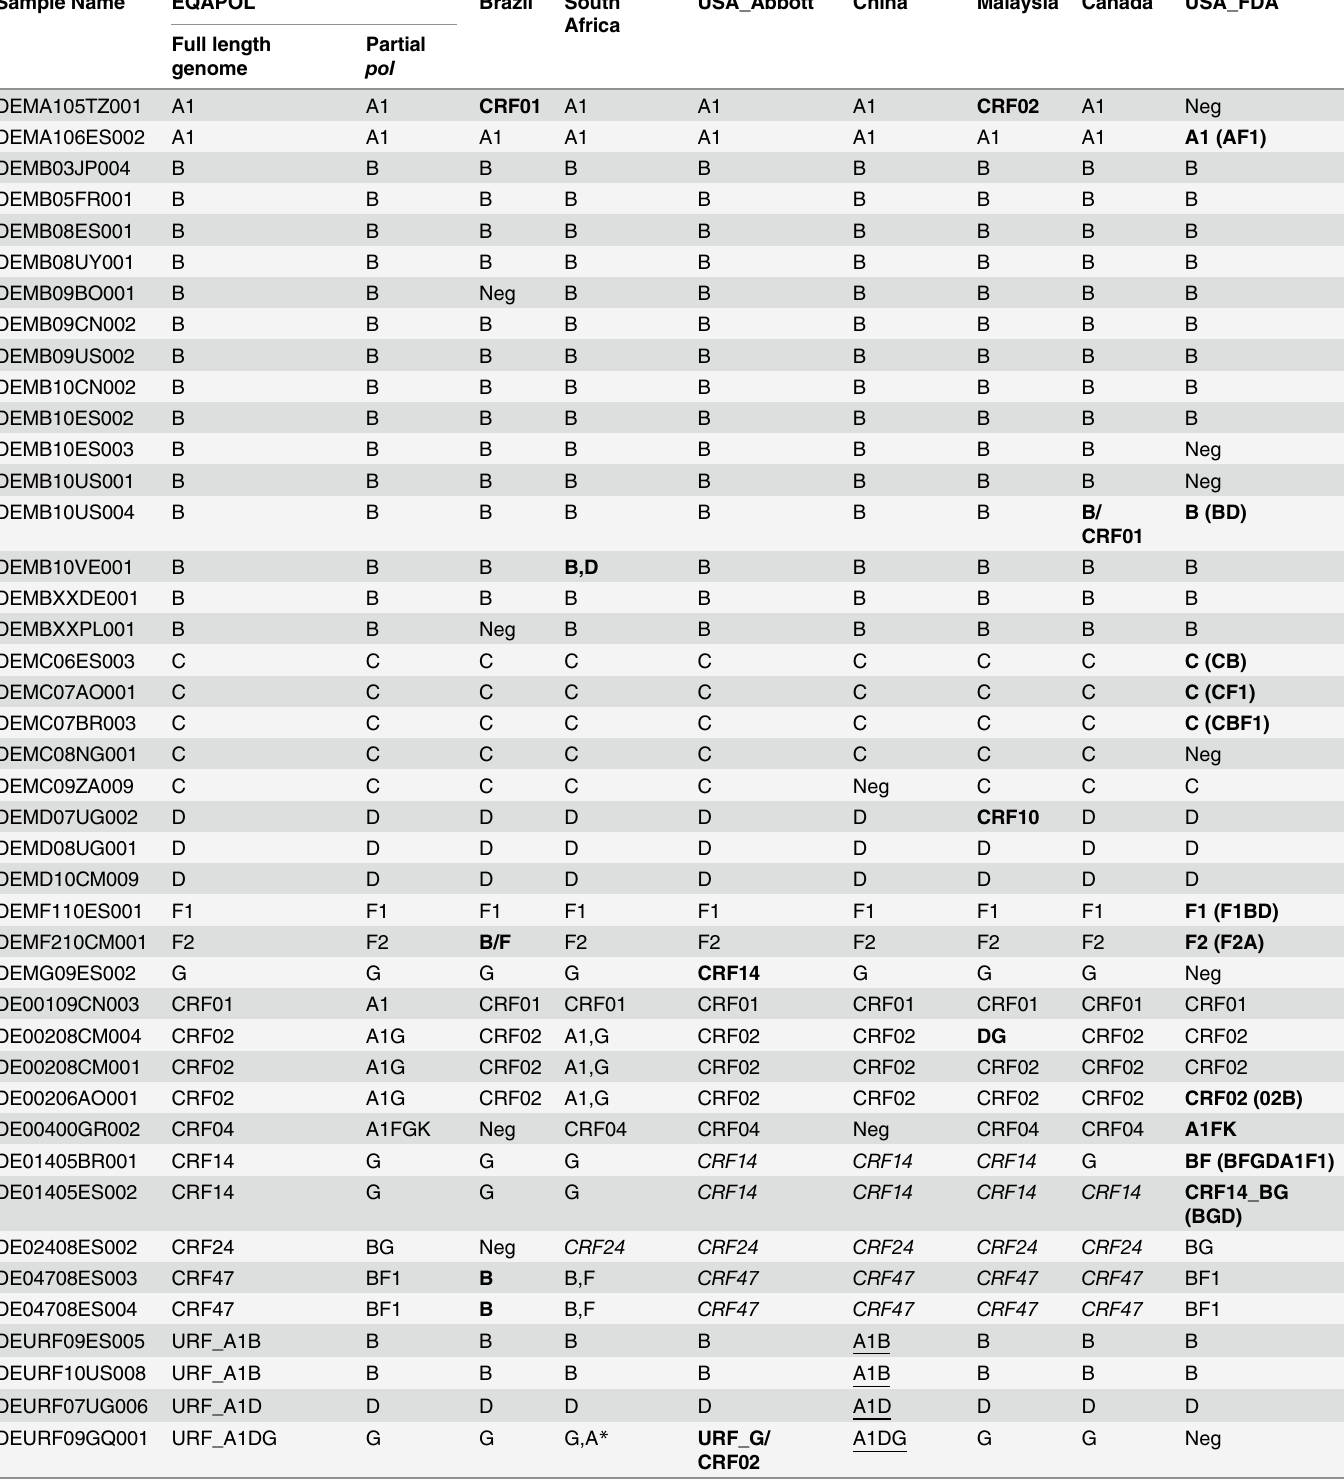
Table 1. Comparison of subtyping results from all